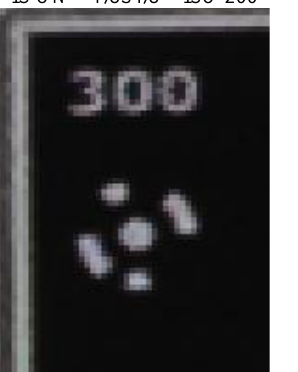
Figure 4. Image quality difference on a target imaged in tests number 5 (IS on) and 6 (IS off) respectively. In order to obtain a sharp image a faster shutter speed was compensated by a higher ISO value. The resulting image is much